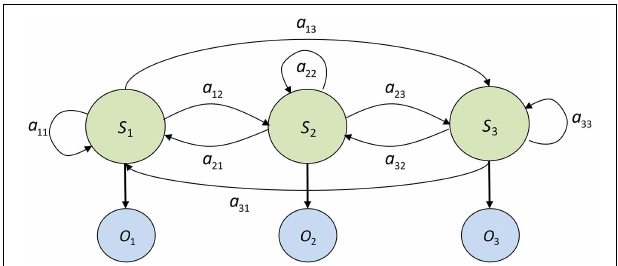
FIGURE 3 | Diagram of a fully connected (ergodic) 3-state Hidden Markov Model. S 1 , S 2 , and S 3 represent the hidden states, O 1 , O 2 , and O 3 are observations emitted by the hidden states, and a ij represents the probability of transitioning from state i to state j .